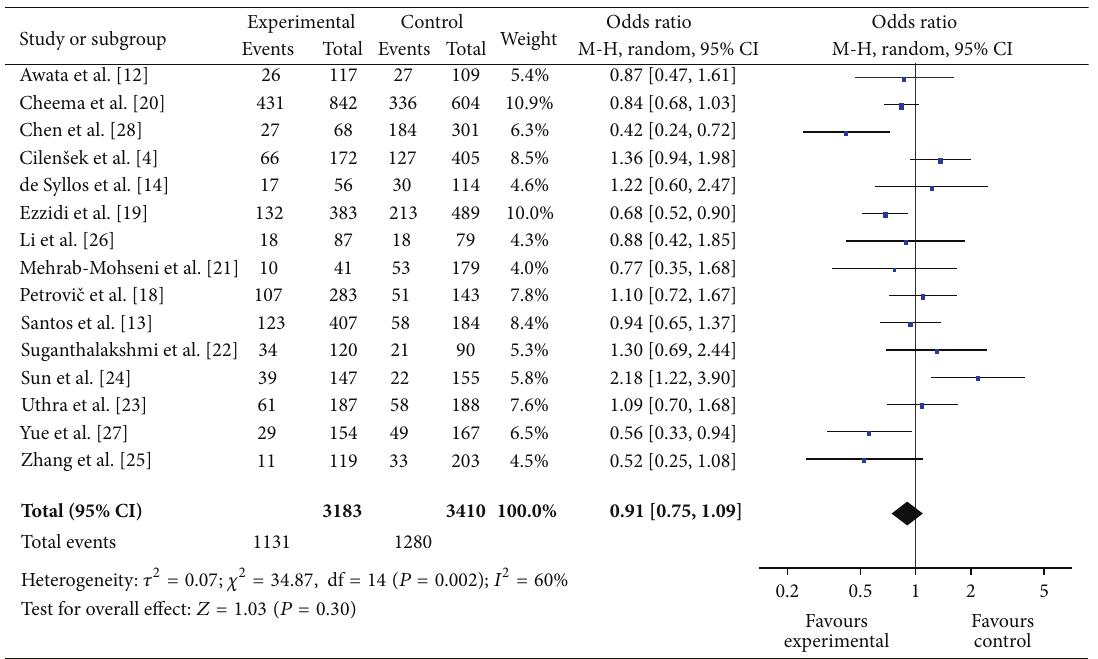
Figure 4: The forest plot of aa + ab versus bb of eNOS polymorphism and overall DR risk.